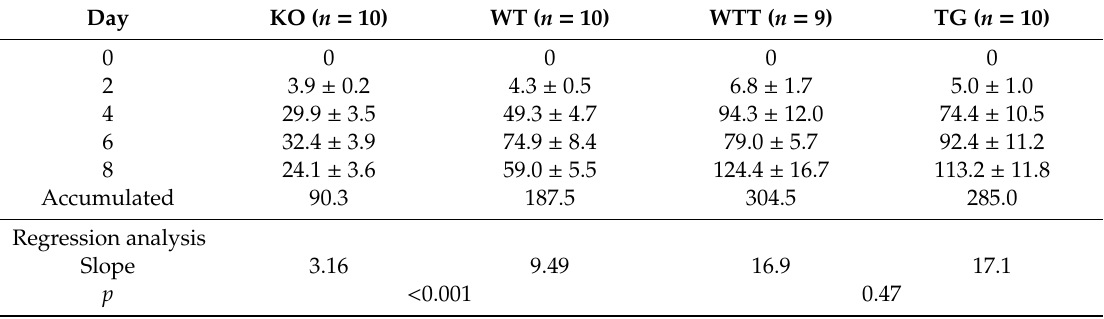
Table 1. Hydroxyproline ( µ g) in conditioned media over eight days of culture (mean ± SEM).